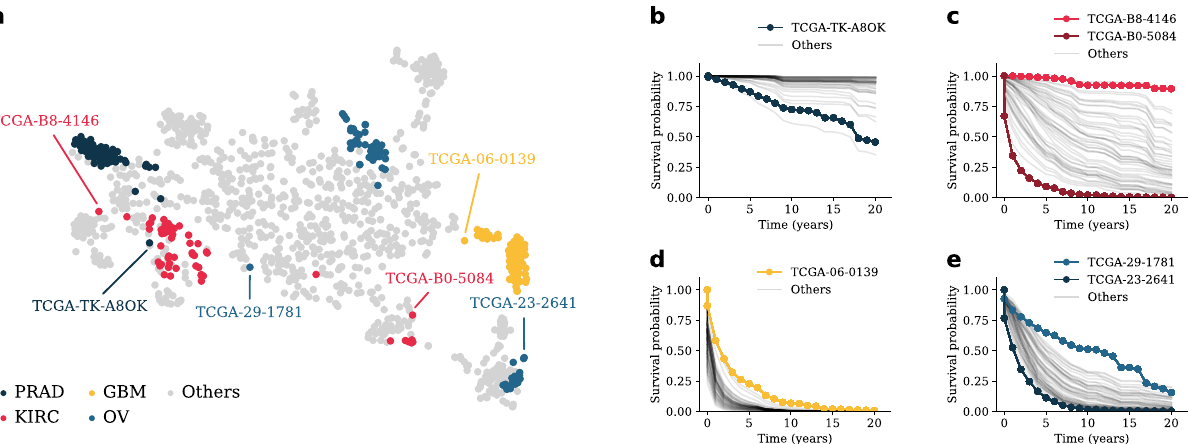
Figure 3. Visualization of feature representations learned by MultiSurv. We collected the internal fused feature representation vector of the MultiSurv model trained on clinical and mRNA data and embedded it into a two-dimensional space using t-SNE. ( a ) Embedded feature representations for each patient in the test dataset. Patients diagnosed with each of four selected cancer types are highlighted. Within each of the highlighted cancer types, visually selected outlier patients are annotated. All patient survival curves, highlighting the selected outliers, are displayed for ( b ) PRAD, ( c ) KIRC, ( d ) GBM, and ( e ) OV. PRAD prostate adenocarcinoma,